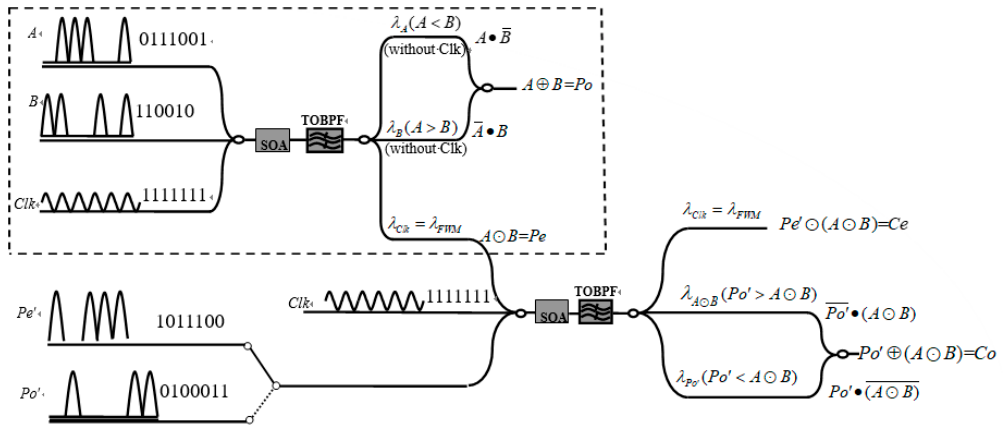
Figure 1. Principle of the all-optical non-inverted parity generator and checker based on semiconductor optical amplifiers (SOAs) ( and are the symbolic representation of exclusive OR (XOR) and exclusive NOR (XNOR), respectively).